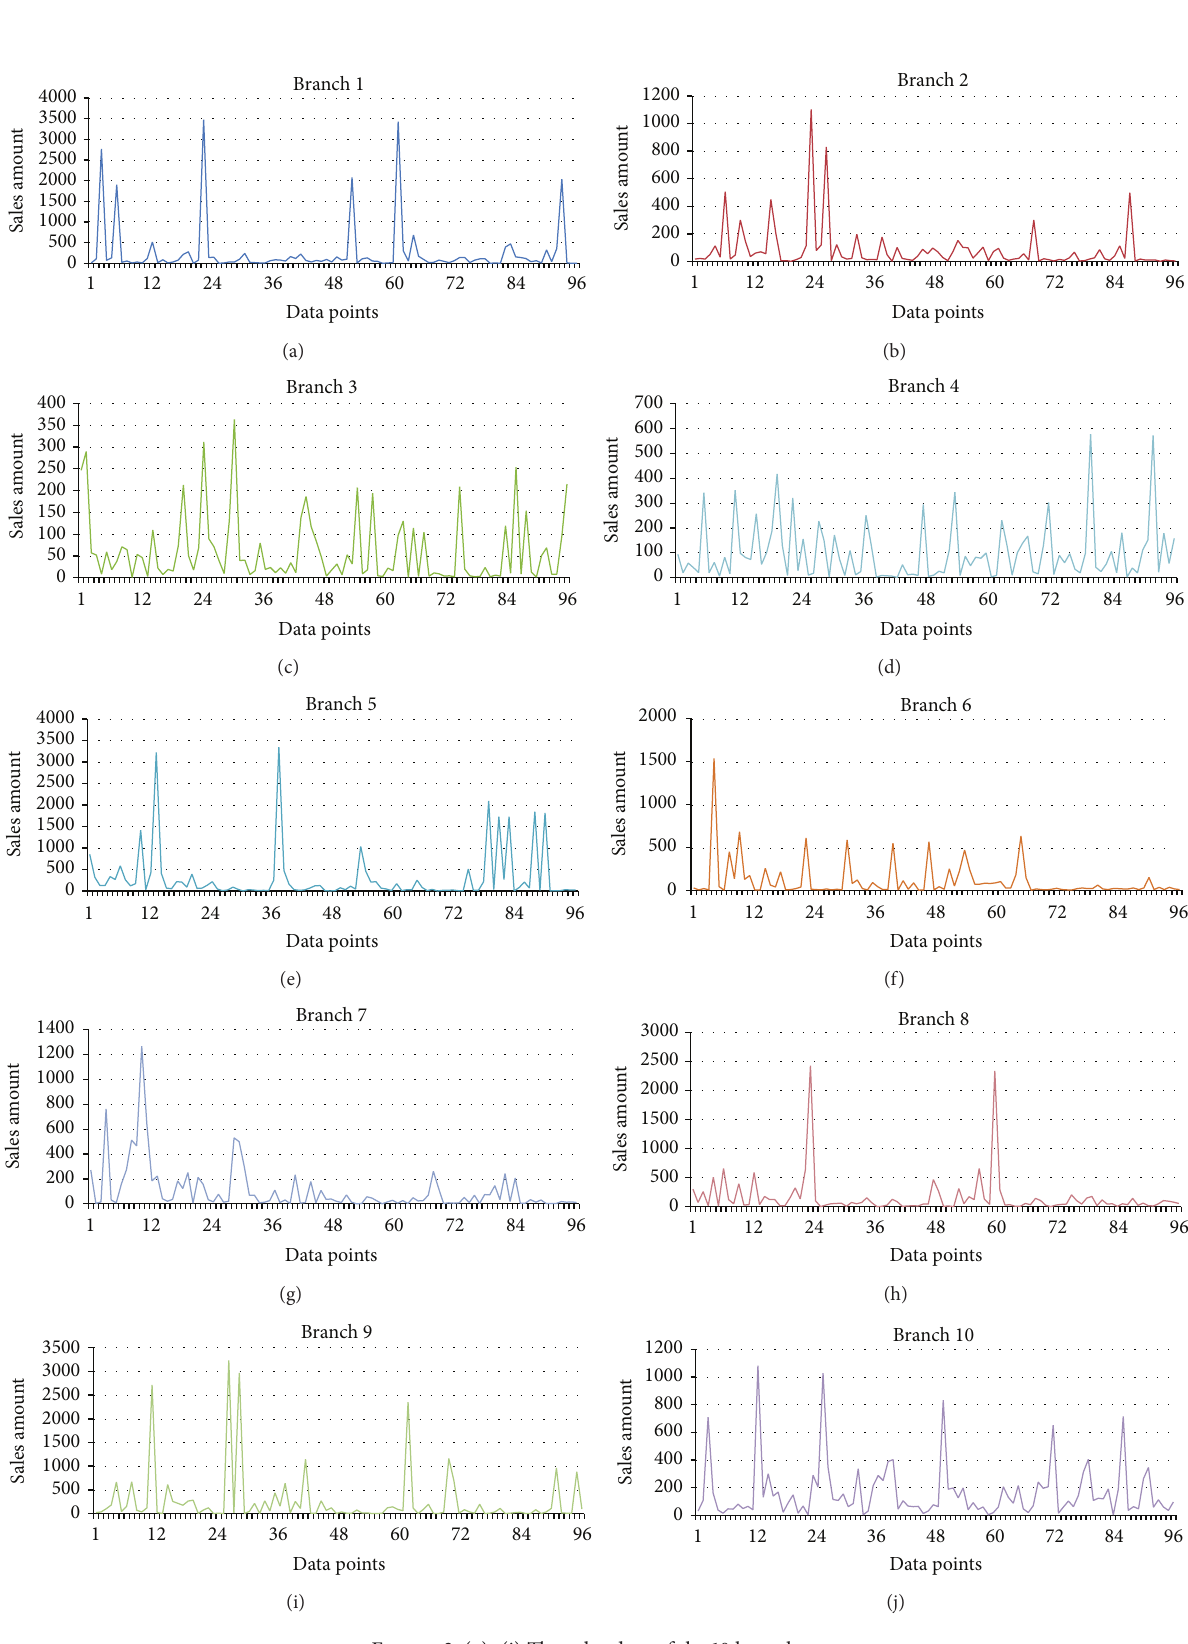
Figure 2: (a)–(j) The sales data of the 10